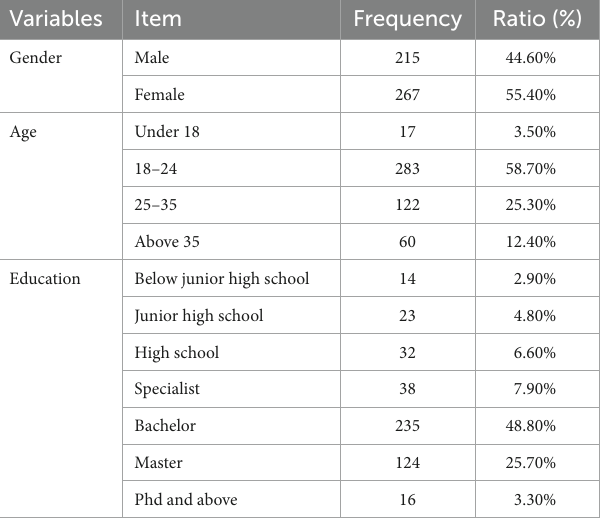
TABLE 1 Demographic characteristics of sample ( N = 482).